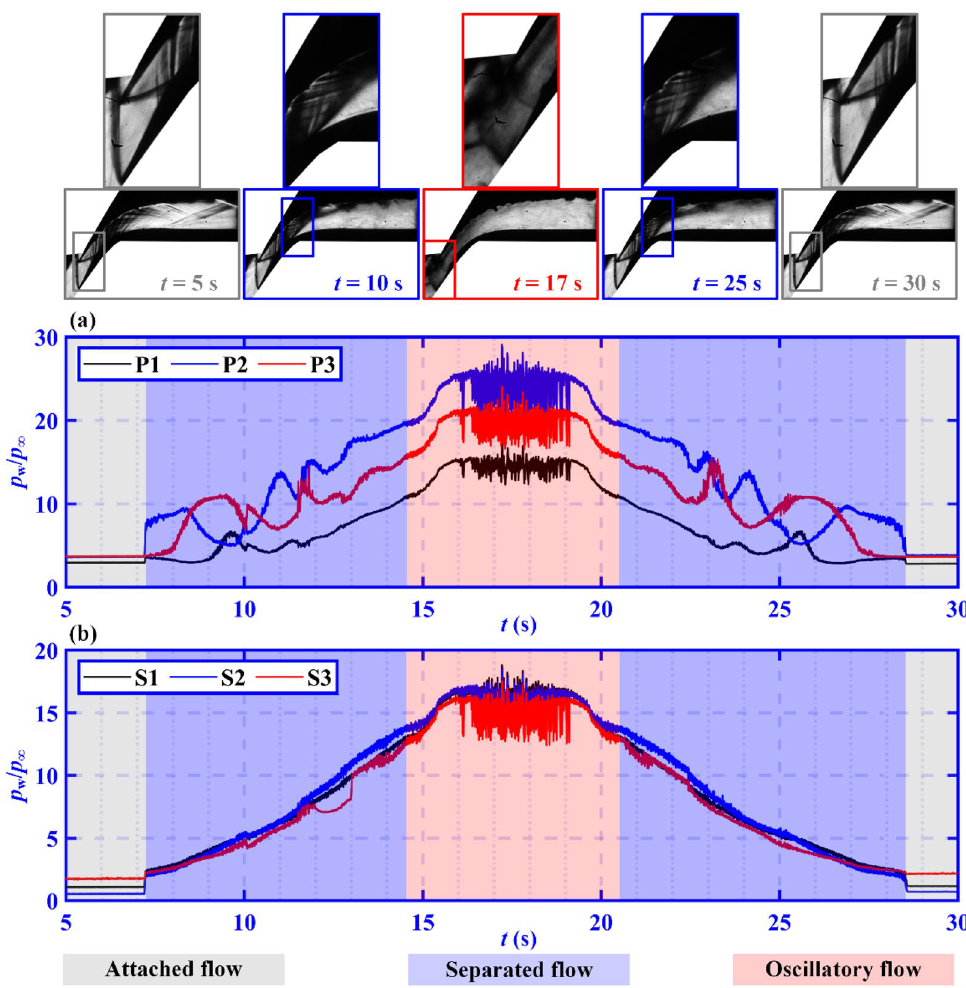
Figure 5. Typical normalized wall pressure–time histories for ( a ) the pressure surface and ( b ) the suction surface. The schlieren images of the flow field at the corresponding times are presented at the